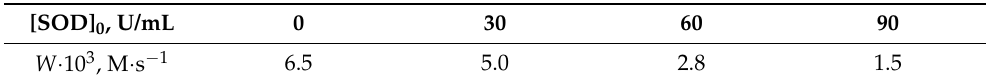
Figure 1. Kinetics of adrenaline consumption in carbonate buffer. pH = 10.60, [Adr] 0 = 68 μ M, air atmosphere, 310 K; B = 0 (1); B = 90 μ T (2); B = 0, [SOD] = 60 U/mL (3); B = 90 μ T, [SOD] = 60 U/mL (4). Table 2. Effect of SOD activity on the rate of adrenaline consumption. Carbonate buffer, pH = 10.60, [Adr] 0 = 68 μ M, air atmosphere, 310 K.